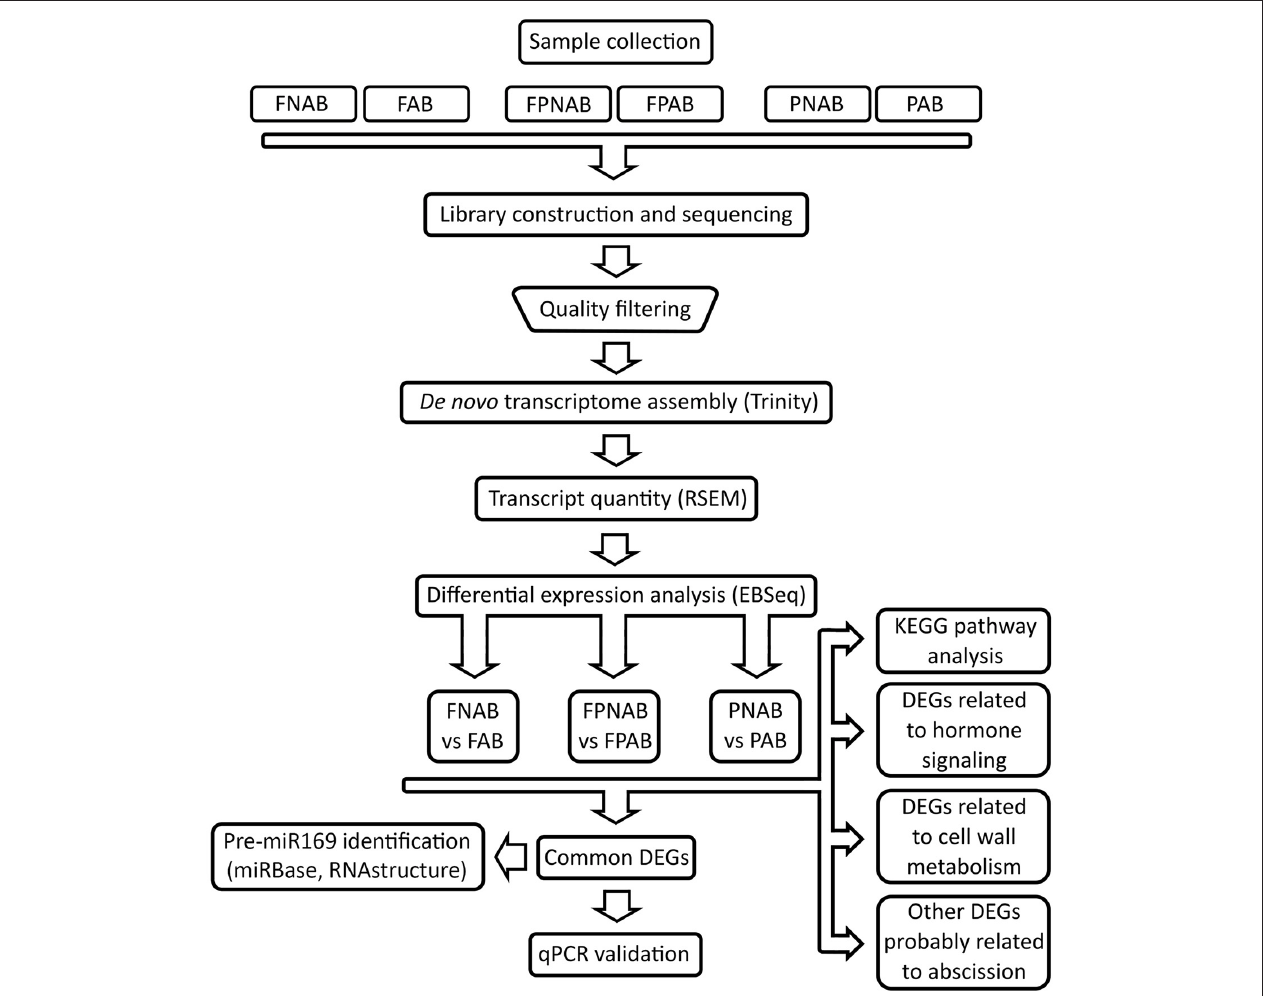
FIGURE 1 | Flowchart representing pipeline for RNA-seq experiments analysis conducted in the study. FAB vs. FNAB-abscising flowers and non-abscising flowers, FPAB vs. FPNAB-abscising flower pedicels and non-abscising flower pedicels, PAB vs. PNAB-abscising pods and non-abscising